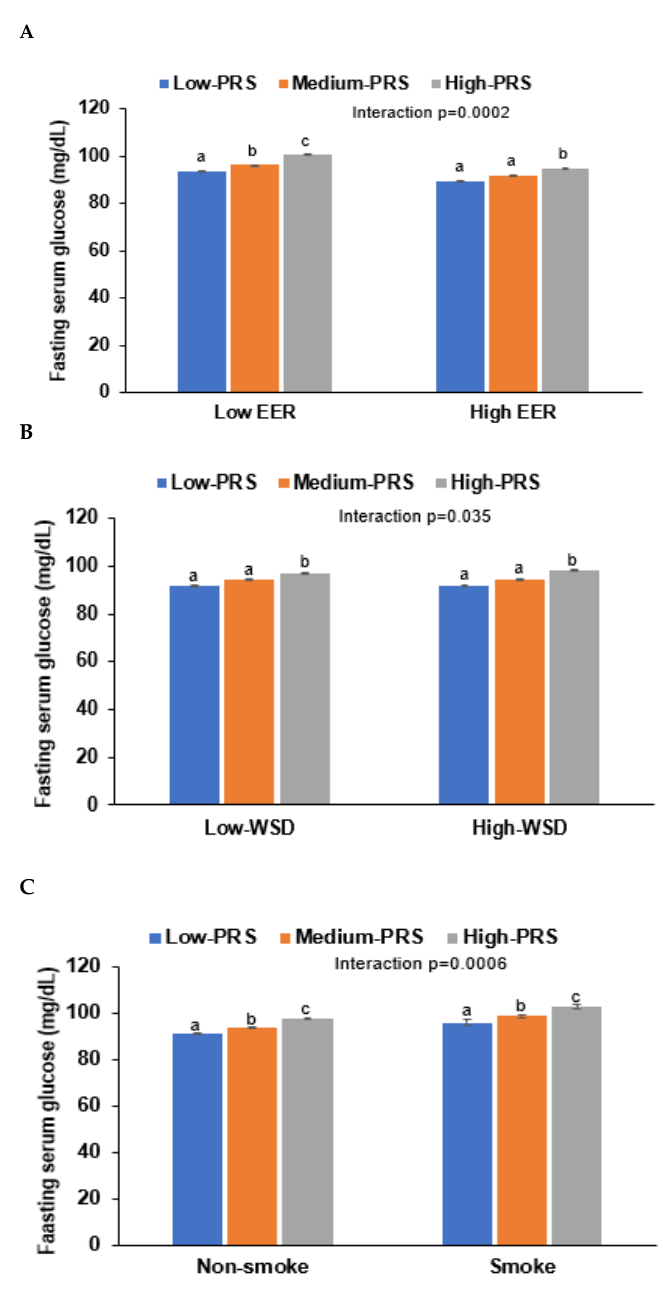
Figure 5. Fasting serum glucose concentrations of participants with low-, medium-, or high-poly- genic risk scores (PRS) as determined using the 8-SNP model: ( A ) Adjusted means and standard errors of the serum glucose concentrations according to PRS categories by daily energy intake (a cutoff value: estimated energy requirement, EER). ( B ) Adjusted means and standard errors of the participants according to PRS categories by a Western-style diet (WSD; a cutoff value: 75th percen- tiles). ( C ) Adjusted means and standard errors of the participants according to PRS categories by smoking status (a cutoff value: smoking). Covariates included age, gender, education, income, energy intake (percentage of estimated energy requirement), occupation, residence area, regular